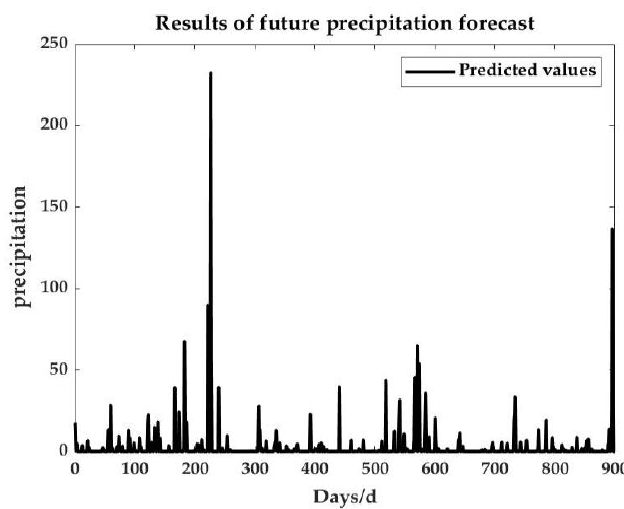
Figure 8. Graph of anticipated results.